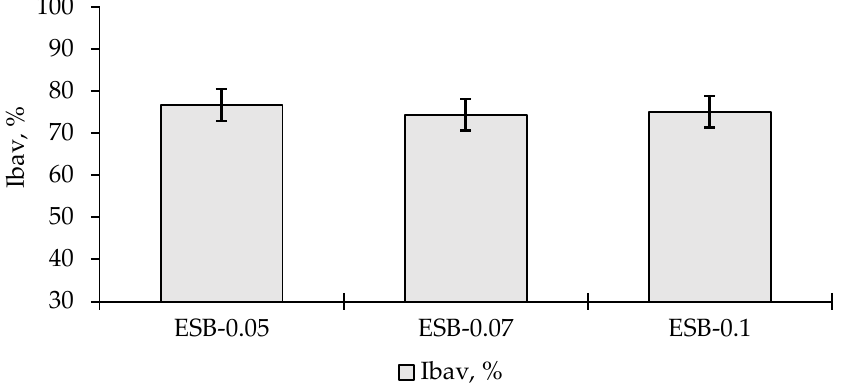
Figure 7. Potential bioavailability (Ibav) of dihydroquercetin.